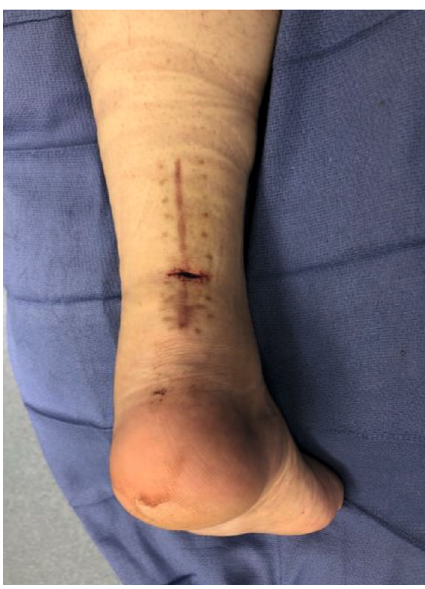
Figure 2: Intraoperative photograph of open rerupture of the achilles tendon. Axis of the wound is transverse and perpendicular to the original surgical